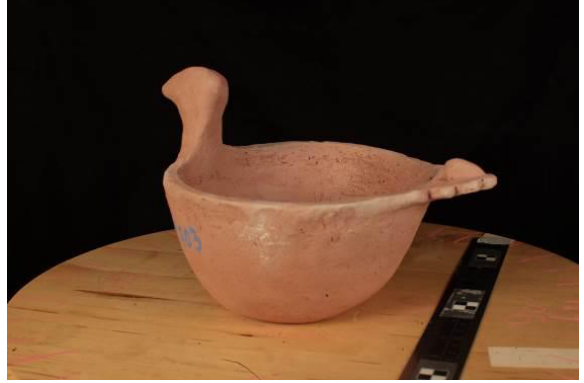
Figure 4: Image with shallow